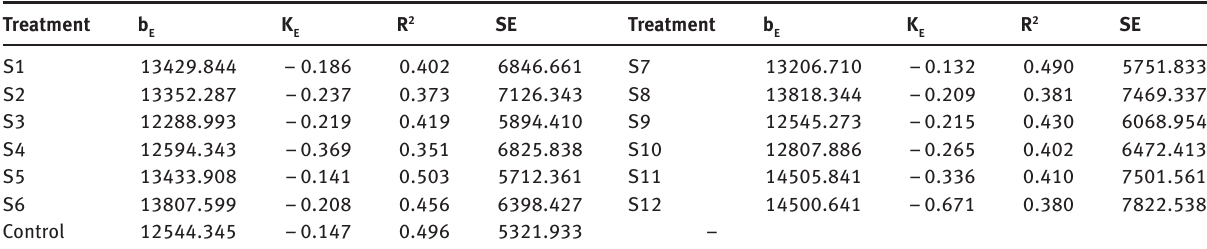
Table 10: Coefficients of the Temkin sorption isotherm, R 2 , and SE for the Cd sorptions of different treatments.